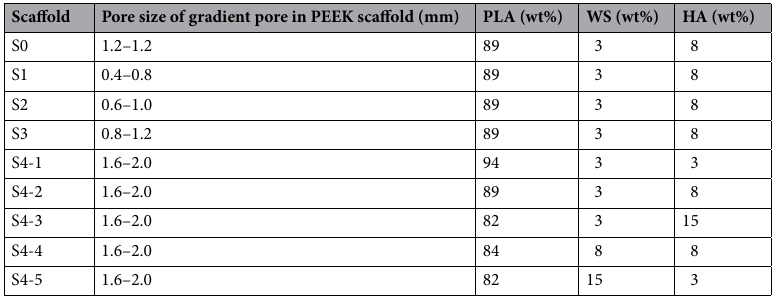
Table 3. Compositions of PEEK-PLA/WS/HA scaffolds.